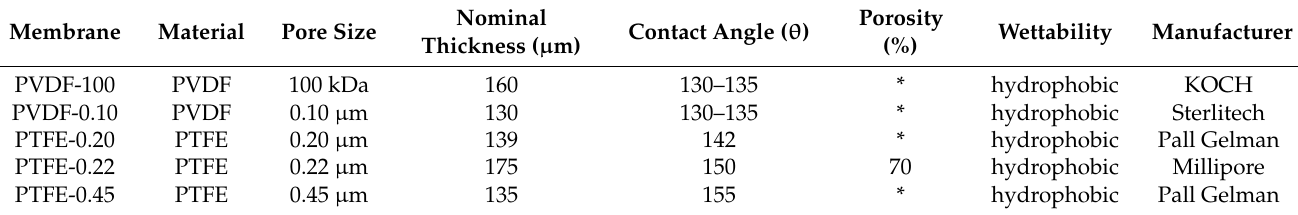
Table 1. Description of the flat sheet membranes studied.